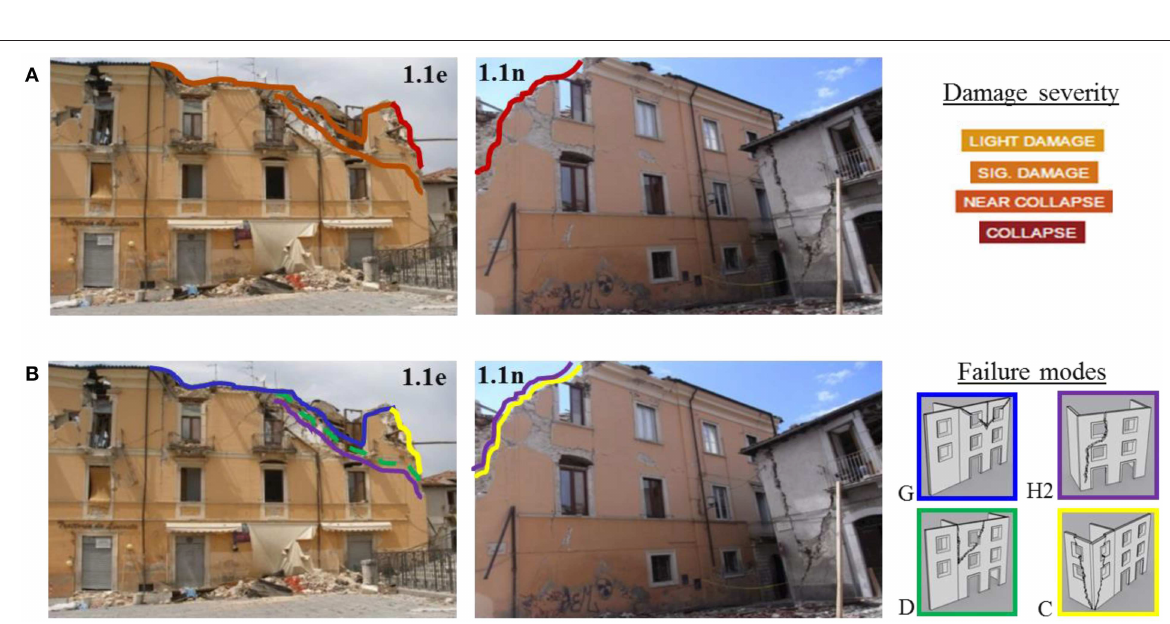
FIGURE 8 | (A) Map of L’Aquila city center, and location of the building 1.1 (red dot); (B) 3D view of the building 1.1. Source: Google MAP.